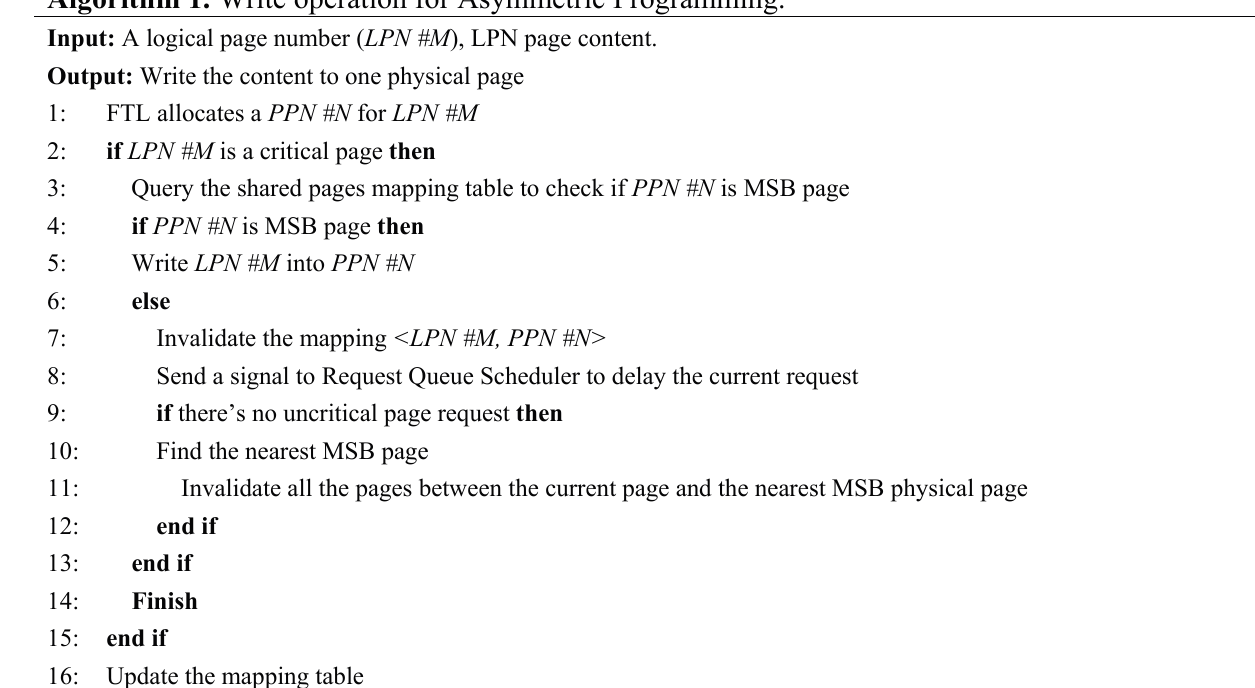
Algorithm 1. Write operation for Asymmetric